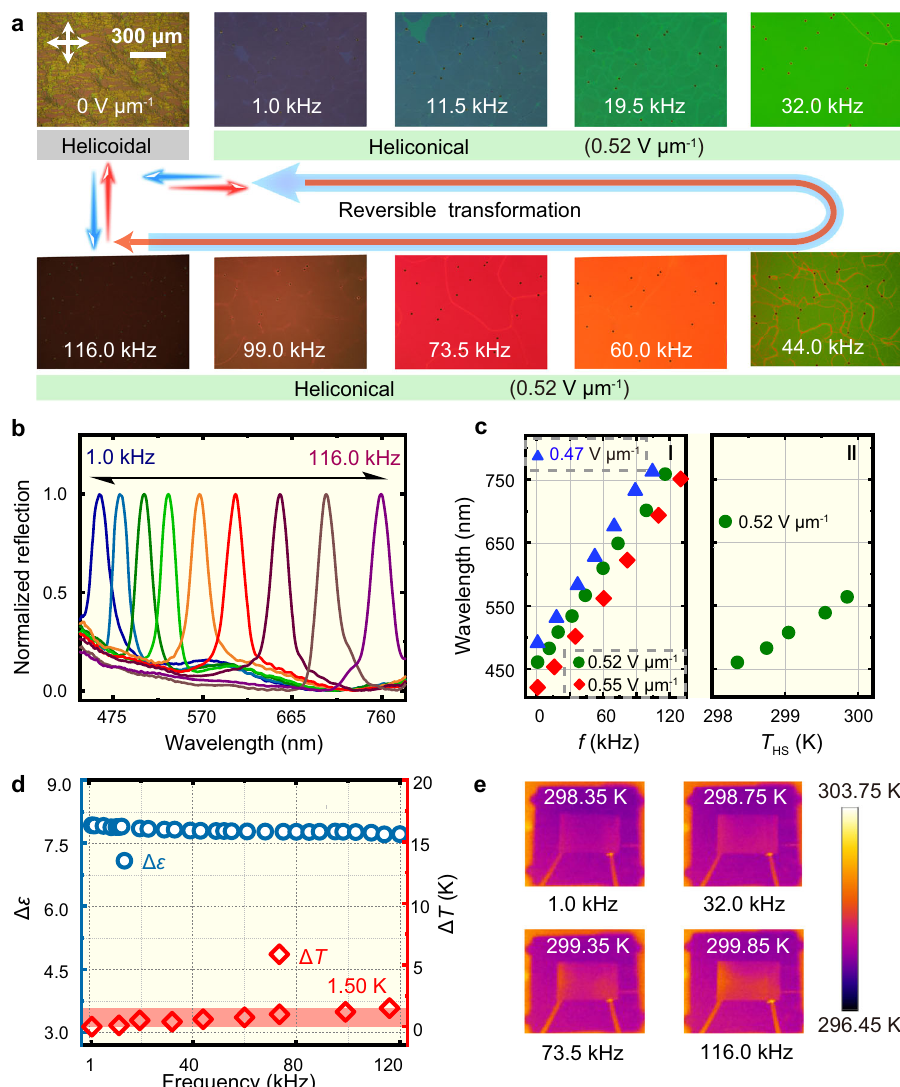
Fig. 2 Wide dynamic spectral range of the re fl ection band obtained by modulating the frequency of the applied electric fi eld. a Polarizing optical microscope (POM) textures of the helicoidal superstructure and the electrically induced heliconical superstructure accompanied by different re fl ection colors when a fi xed electric fi eld strength (i.e., 0.52 V μ m − 1 ) with increasing frequency from 1.0 to 116.0 kHz. Orthogonal double-arrows means the crossed polarizers. The scale bar is 300 μ m. b The corresponding re fl ection spectra of the POM textures when the electric fi eld strength (i.e., 0.52 V μ m − 1 ) was constant. c Frequency-dependent central wavelength of the re fl ection bands at various electric fi eld strengths (I) and the evolution under a direct change in temperature ( T HS ) controlled with a hot stage from 298.35 to 299.85 K under fi xed electric fi eld strength and frequency (i.e., 0.52 V μ m − 1 and 1.0 kHz) (II). d Almost unchanged dielectric anisotropy Δ ε and the slight change in sample temperature ( Δ T ) of 1.50 K at 0.52 V μ m − 1 under increasing frequency from 1.0 to 116.0 kHz. Δ T was de fi ned as T – T 0 , and the initial temperature T 0 of the sample at 1.0 kHz was 298.35 K. e Infrared temperature measurement of the sample with increasing electric fi eld frequency by a thermal imager. The sample was located in the center of the rectangular area. Source data are provided as a Source Data fi